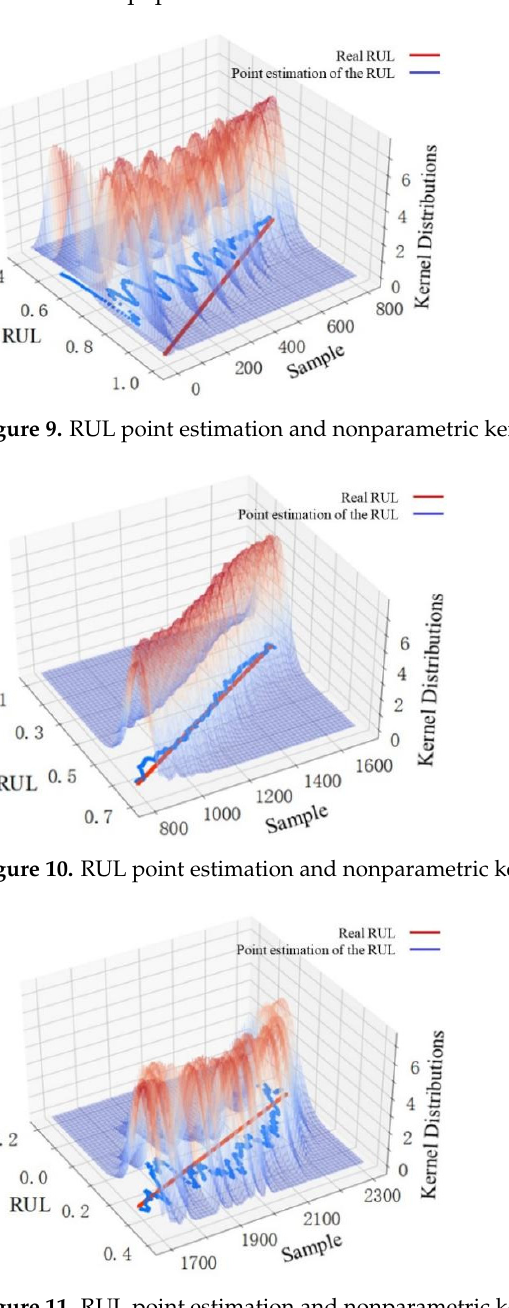
Figure 11. RUL point estimation and nonparametric kernel density distribution in the third stage.